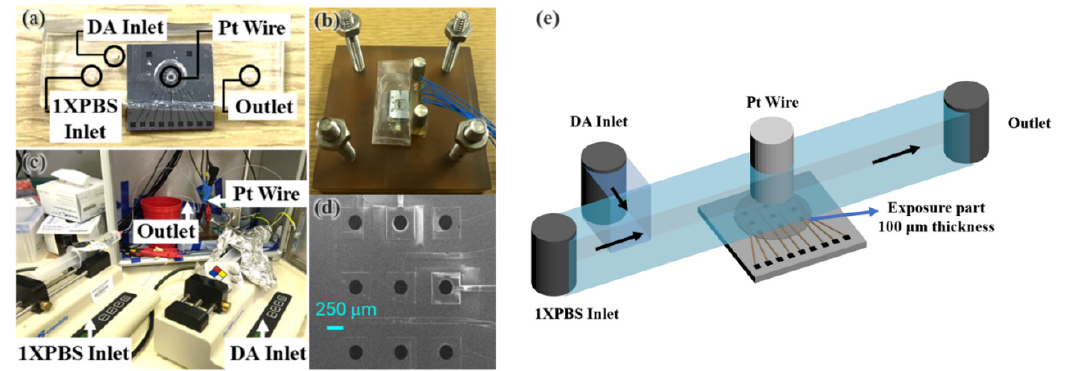
Figure 1. ( a ) Optical picture of an integrated boron-doped ultrananocrystalline diamond (BDUNCD) chip—microfluidic platform. ( b ) Optical picture of an assembled system with electrical connections. ( c ) Experimental setup showing connections to the micro syringe pumps and the potentiostat. ( d ) SEM image of a 3 × 3 BDUNCD microarray chip. ( e ) Schematic showing the integration of microfluidics with the BDUNCD chip.